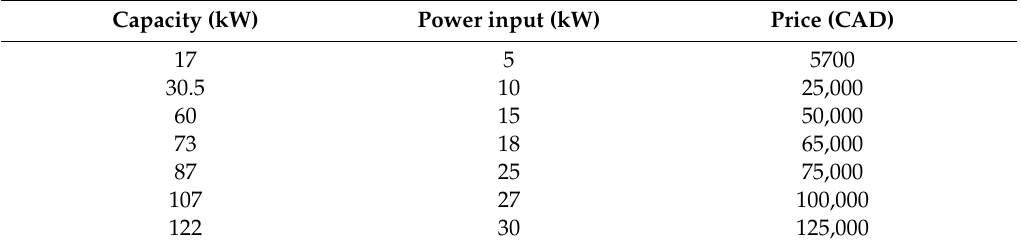
Table 6. Capacity, cost and electrical power consumption of several geothermal pumps [88]. Capacity